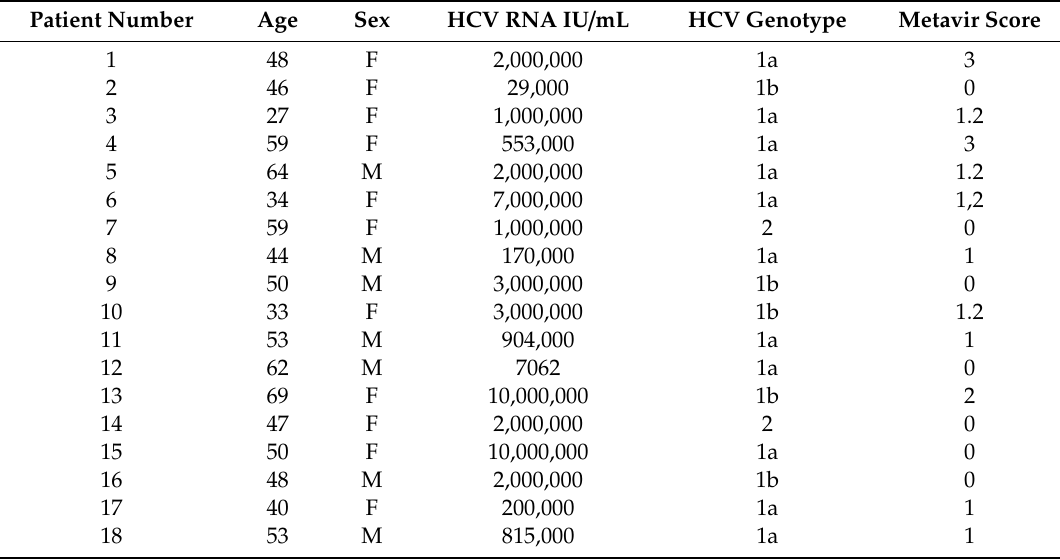
Table 1. Characteristics of the patients with Chronic Hepatitis C.